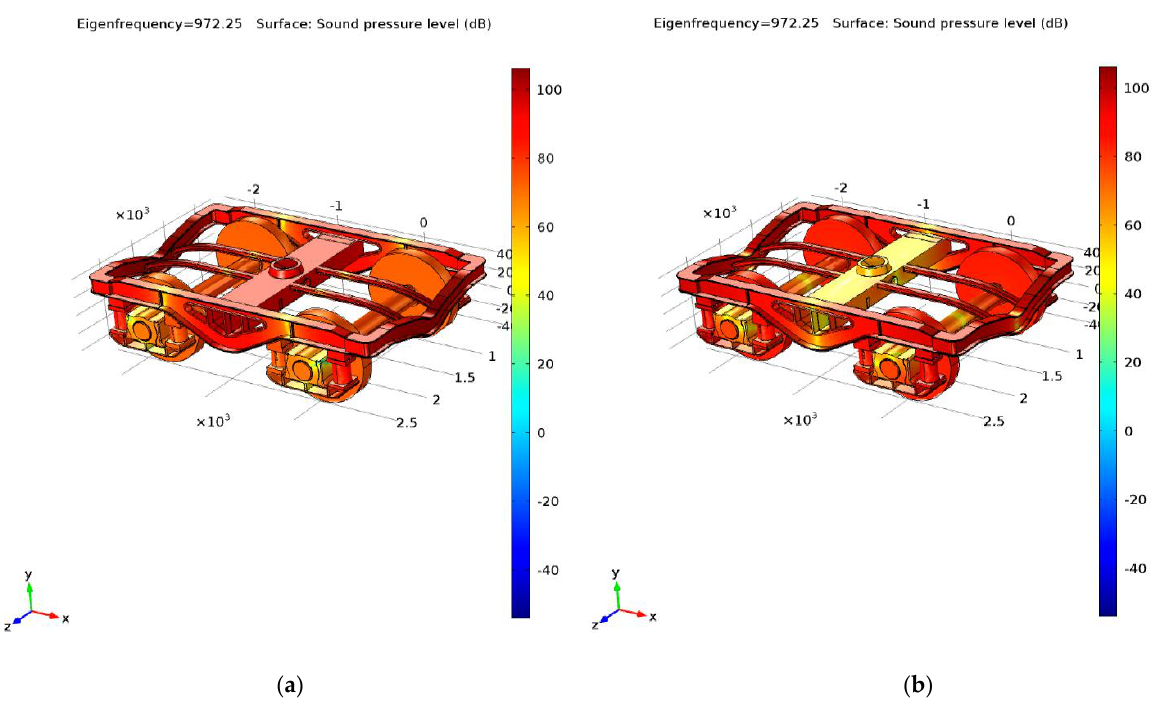
Figure 10. Simulations results for eigenfrequency of 972 Hz: ( a ) before material application to main bogie member, and ( b ) after application.